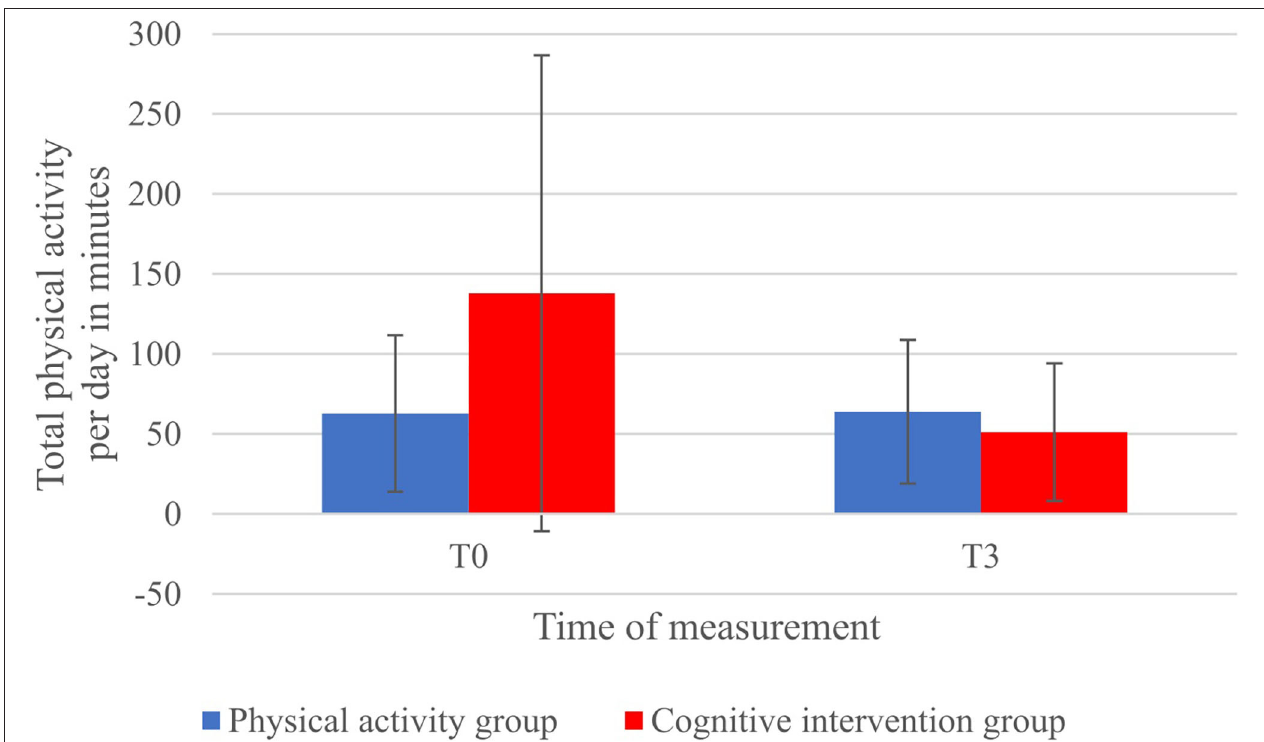
FIGURE 3 | Changes in mean total physical activity per day in minutes as measured by the Global Physical Activity Questionnaire (GPAQ; Armstrong and Bull, 2006) from T0 (baseline measurement) to T3 (end of semester) in dependence of group. Figure shows significant group × time interaction. Error bars depict standard deviations. p < 0.05.